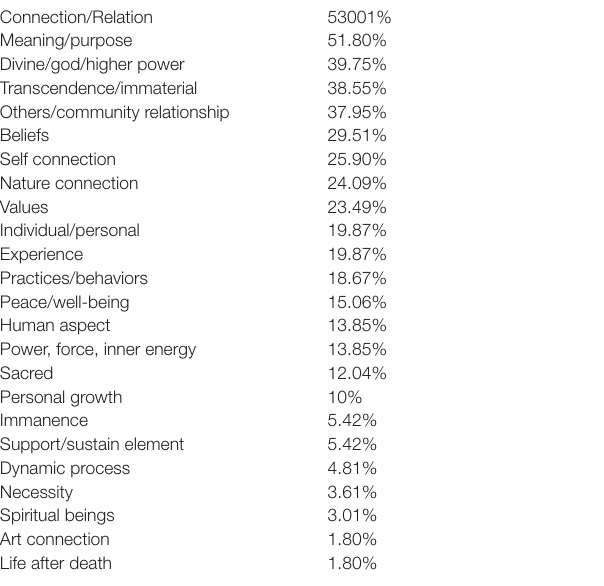
TABLE 3 | Spirituality